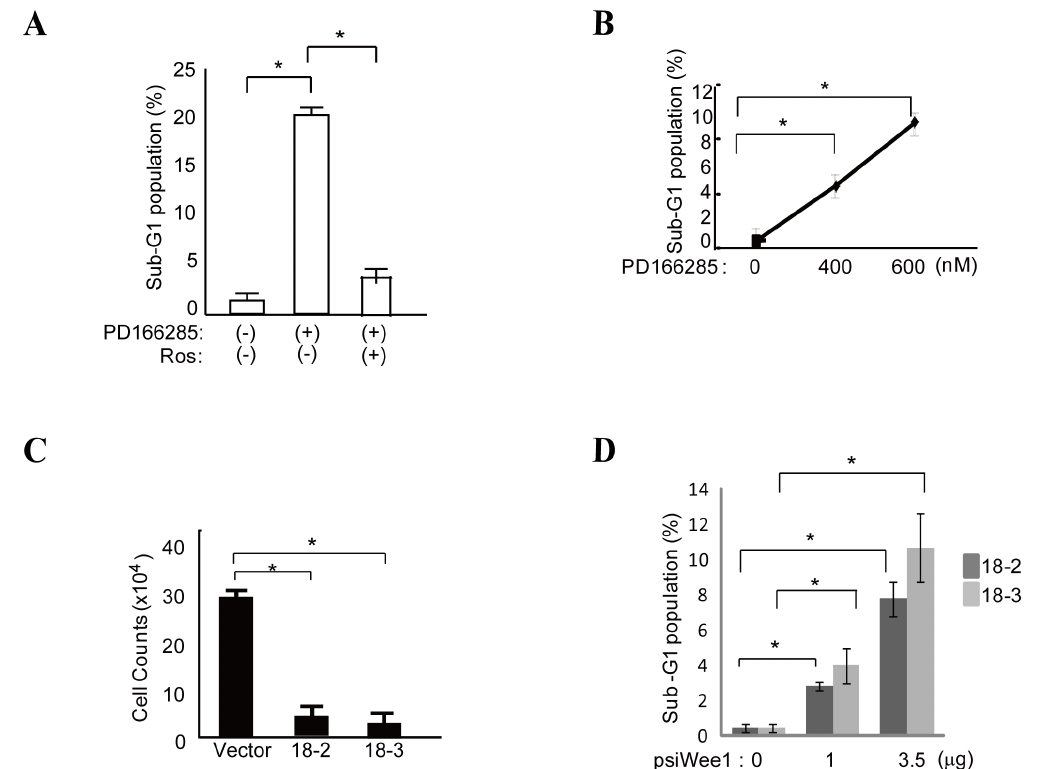
Figure 2. Targeting Wee1 kinase induces apoptosis in HCC cells. A, The number of sub-G1 HuH7 cells significantly increased after PD166285 treatment (200 nM). PD166285-mediated apoptosis of HuH7 cells was completely inhibited by pretreatment with 20 m M roscovitine (Ros). * indicates significant differences between each group (P , 0.05). The results are presented as means 6 S.D. of three experiments. B, PD166285 decreased the number of HuH7 cells in a concentration-dependent manner after 72 h. * indicates significant differences between each group (P , 0.05). The representative results of three independent experiments are shown. C and D, Wee1 kinase-specific siRNAs (18-2 or 18-3) significantly reduced the total number of cells and increased the sub-G1 cell population 48 h after transfection in a concentration-dependent manner compared with control- vector transfectants. * indicates significant differences between each group (P , 0.05).